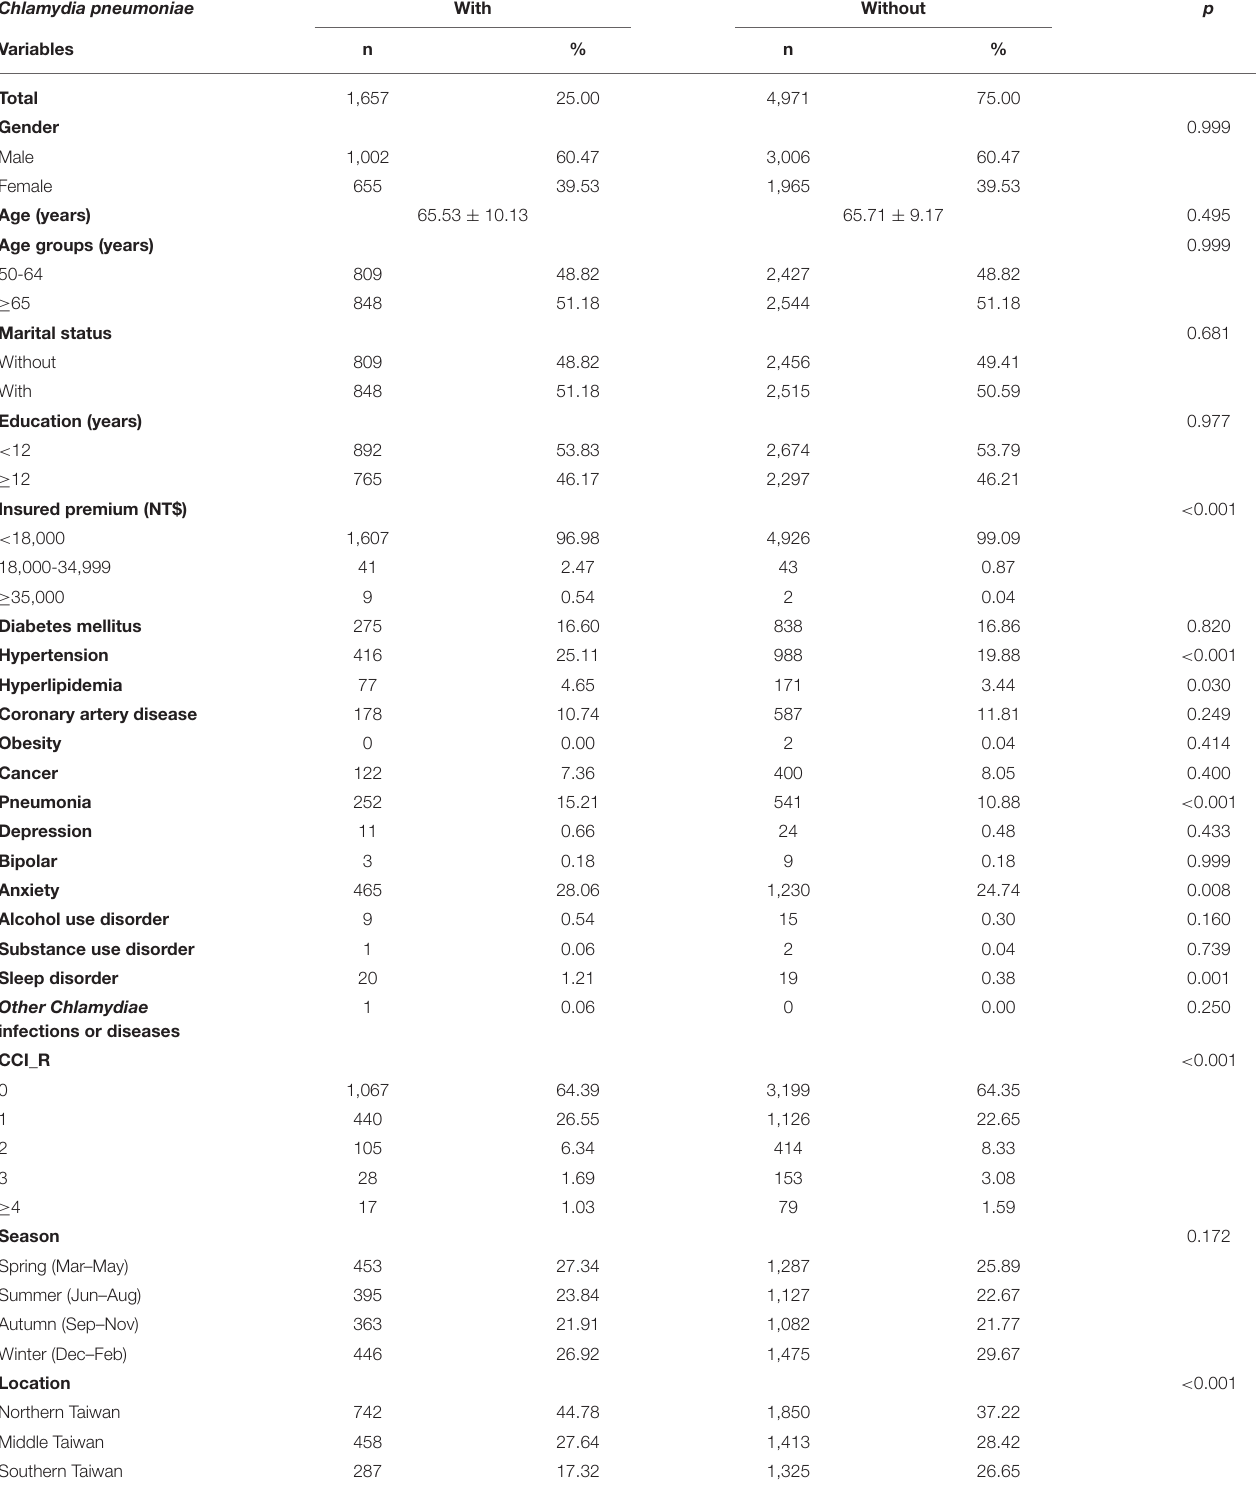
TABLE 1 | Characteristics of study at the baseline. Chlamydia